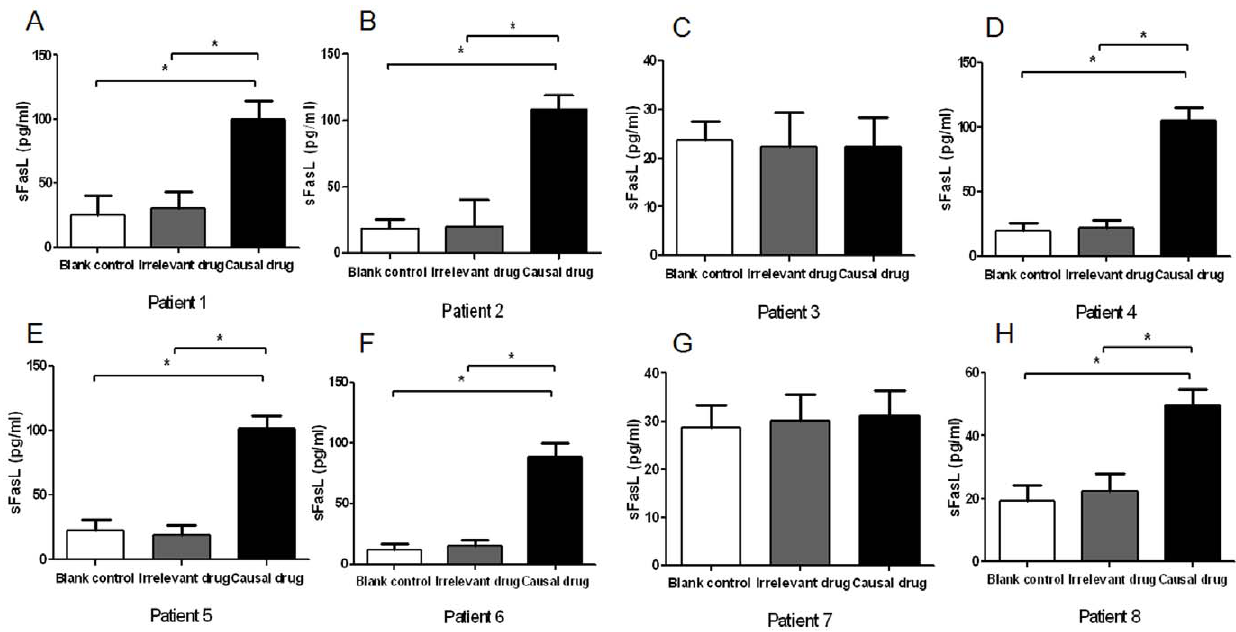
Figure 3. sFasL levels in supernatants of drug-stimulated PBMCs from SJS and TEN patients. PBMCs from patients with SJS and TEN were cultured with causal drugs, irrelevant drugs, or medium alone for 3 days. The supernatants were collected and the concentrations of sFasL were determined by sFasL ELISA kit. A–H, Patient 1–8. The graphs show the means of three samples of each patient and error bars represent SD values. *P , 0.05.